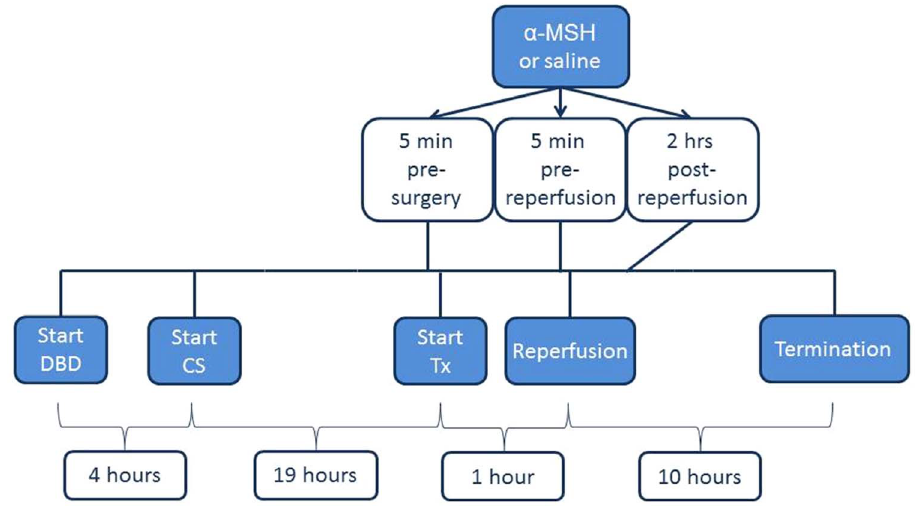
Figure 1. Study design.